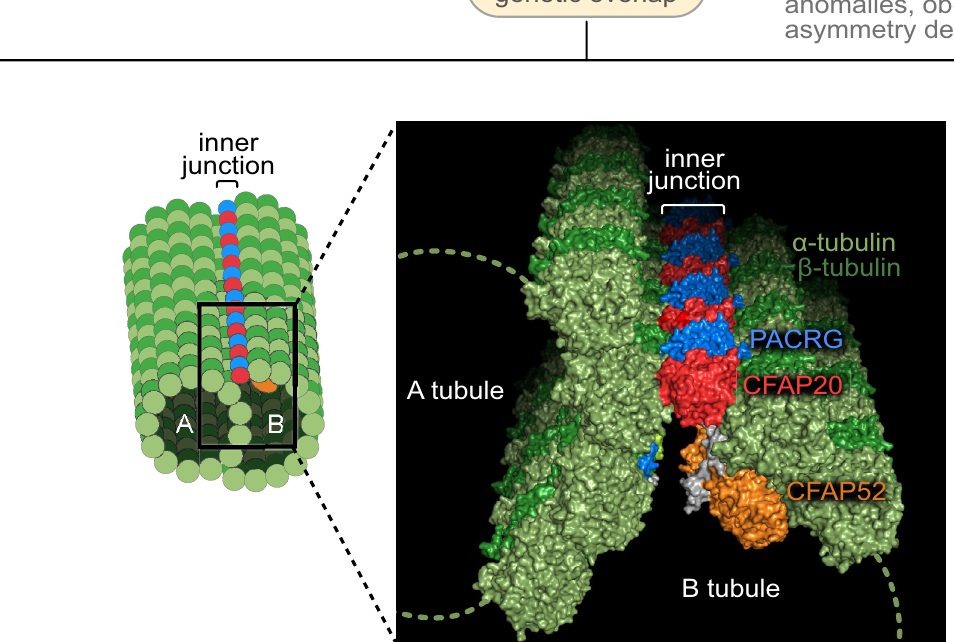
ciliopathies. b This study focusses on the protein CFAP20 (red). From recon- structionsofmotileciliain Chlamydomonas and Tetrahymena ,CFAP20isknownto form a repeating unitwith PACRG (blue); these formthe coreofthe innerjunction (IJ) that runs the length of each microtubule doublet. The IJ participates in attachment of the B tubule to the A tubule to complete each of the nine doublet microtubuleaxoneme.TheinnerjunctionstructureshownisderivedfromPDB fi le 6VE7 21 . TZ transition zone, BB basal body, L-R